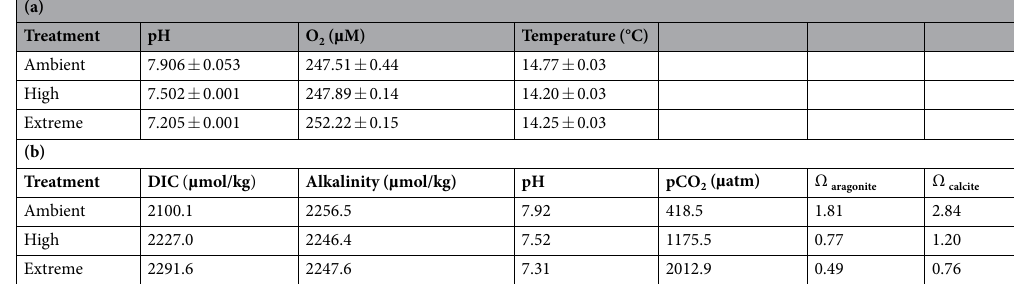
Table 1. (a) Water chemistry set points (mean ± 1 SE) in gas-control tanks at MBARI, measured continuously every 60 seconds between March 7 and July 10, 2013. (b) Water chemistry as measured in the bins containing coralline algae and calculations of pCO 2 and Ω (from pH and total alkalinity). Salinity was 33.9 ± 0.05